Question: Express in one sentence what the figure is showing.
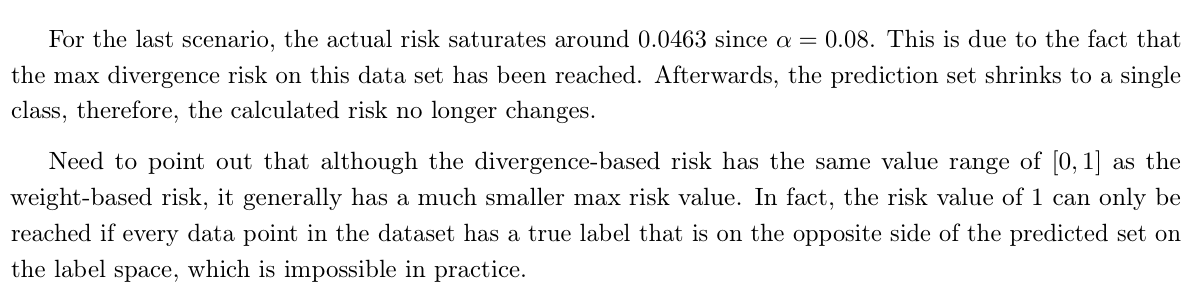
Answer: illustrates the trend of prediction set sizes at different values of α for these scenarios. It can be seen that as the value of α increases, the set sizes reduce. For the divergence-based risk, the set size shrinks to 1 around α = 0.05, which aligns with the calculated max risk value 0.0463. The figure also shows that, for the weight-based risk, both the incremental weights and the double weights scenarios have larger prediction sets compared with the equal weights scenario on the same α value. This is because the algorithm needs to extend the prediction set accordingly to reduce the overall risk. Therefore, there is a trade-off between the prediction set size and the risk reduction.